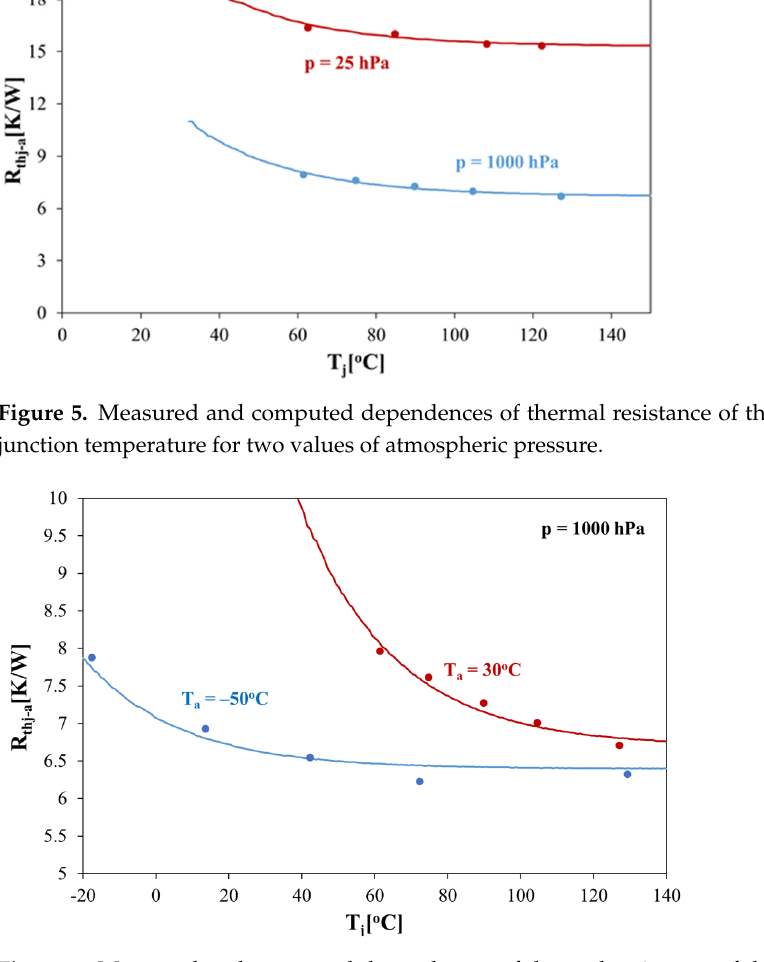
Figure 6. Measured and computed dependences of thermal resistance of the tested diode on the junction temperature for two values of ambient temperature .